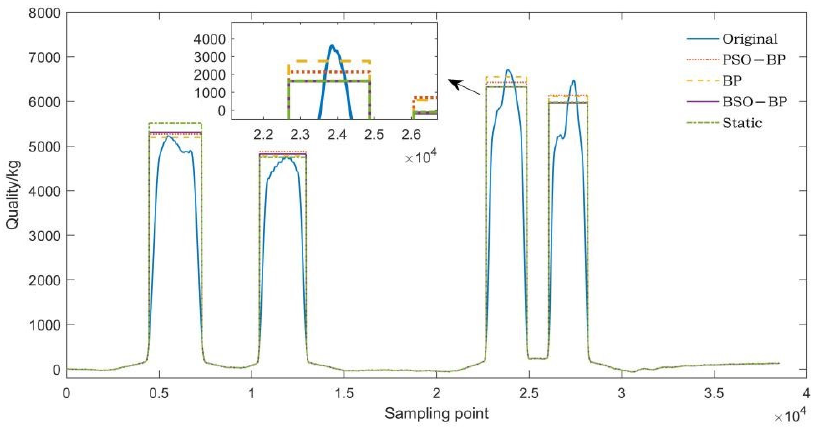
Figure 11. Corrected axle weight waveform comparison of a four-axle vehicle.